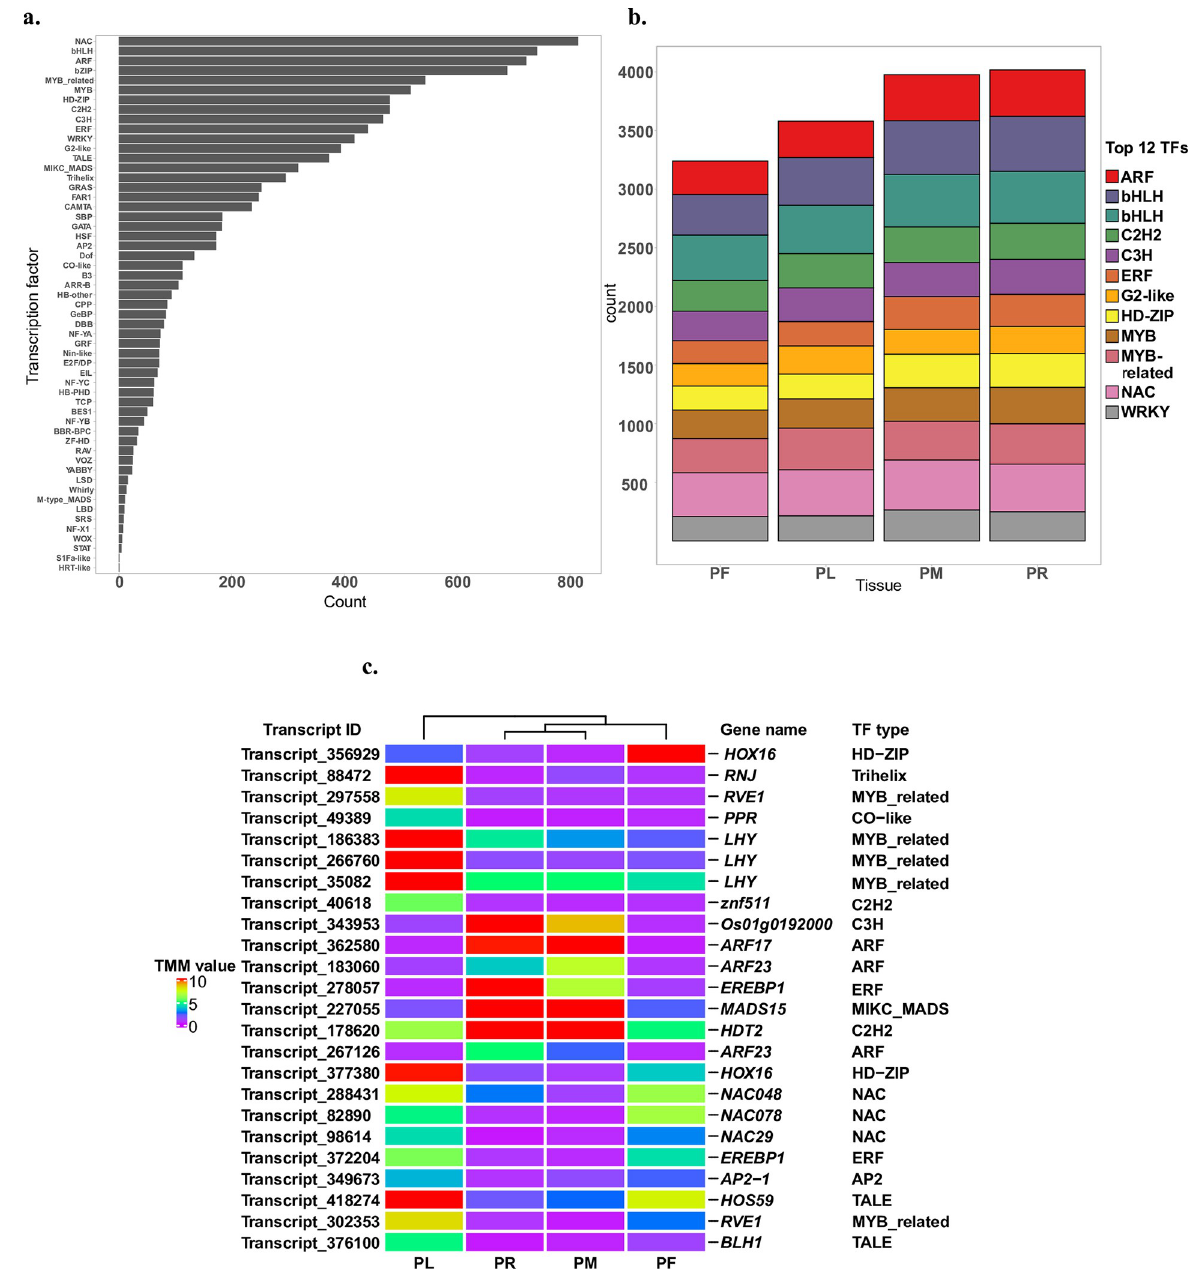
Fig 6. TFs identified in P . australis transcriptome assembly “cd_hit”. a. The distribution of all 55 types of putative TFs in P . australis transcriptome; b. The number of the top 12 types of putative TFs in each tested tissue. If the TF has the expression in that tissue from the normalized expression matrix, it would be counted; c. Heatmap of the TFs showing the tissue-specific expression pattern. Putative types of TFs and matched gene names are listed as well, which are from the UniProt-Swissprot annotation. Heatmap was generated from the R package ComplexHeatmap [53]. Red depicts a higher TMM value and purple depicts a lower TMM value. PL: leaf, PF: inflorescence, PM: shoot meristem, and PR: